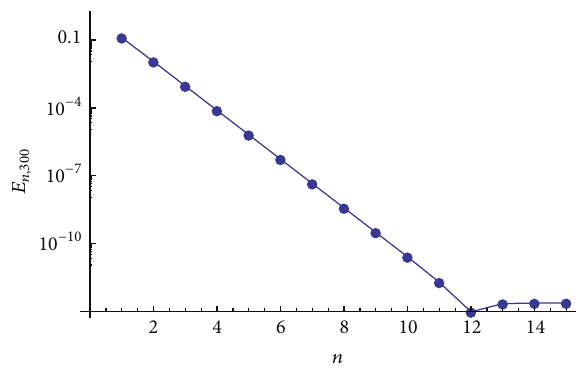
Figure 3: Maximum absolute error related to each iteration in Example 2.